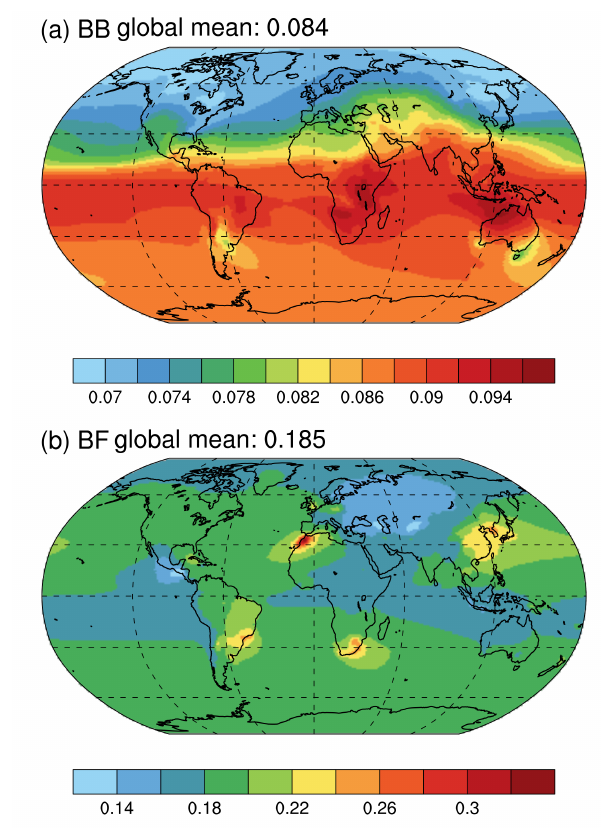
Figure 2. The ratio of column averaged burden of black carbon to POM of (a) biomass burning (BB) and (b) biofuel burning (BF). Note the different